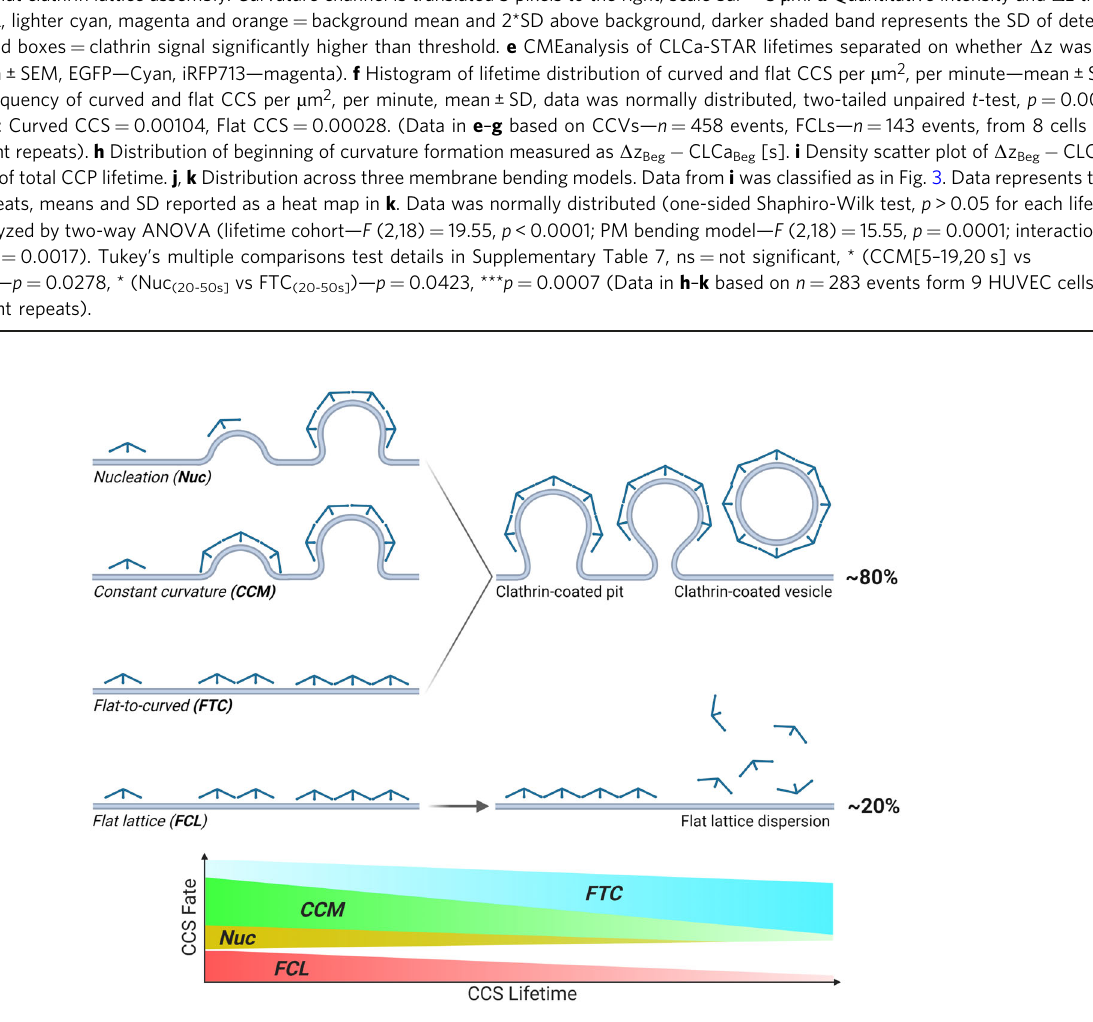
is corrected for chromatic aberration using the NanoGrid fi le and written by us image registration MATLAB script (IMGREG.m). Post-registration 647nm channel images are divided by theirs unregistered version. Created ratio image is then used to measure the mean interpolation generated through image registration (measured as σ ). First, ROI around the cell border is drawn, followed by measuring the mean signal within. In our data, on average σ = 1.01. This value is then used to apply a gaussian blur onto all the pictures of the 488 nm channel. Then Δ z channel was generated by using written by us Fiji plugin (dz_channel_generator.ijm) that will automatically run further steps described in Supplementary Fig. 2b and save the data that can be then used for data analysis. EPI/STAR analysis . STAR images were acquired as described above alternately with epi fl uorescence images using the Sola light source (Lumencor) and the 96362 ET GFP C180702 fi lter cube. An image set was acquired every 1.25 s with 200 ms exposure. Cohorts with a mean of 2 or less events per cell were discarded from quanti fi cations in Supplementary Fig. 6c.